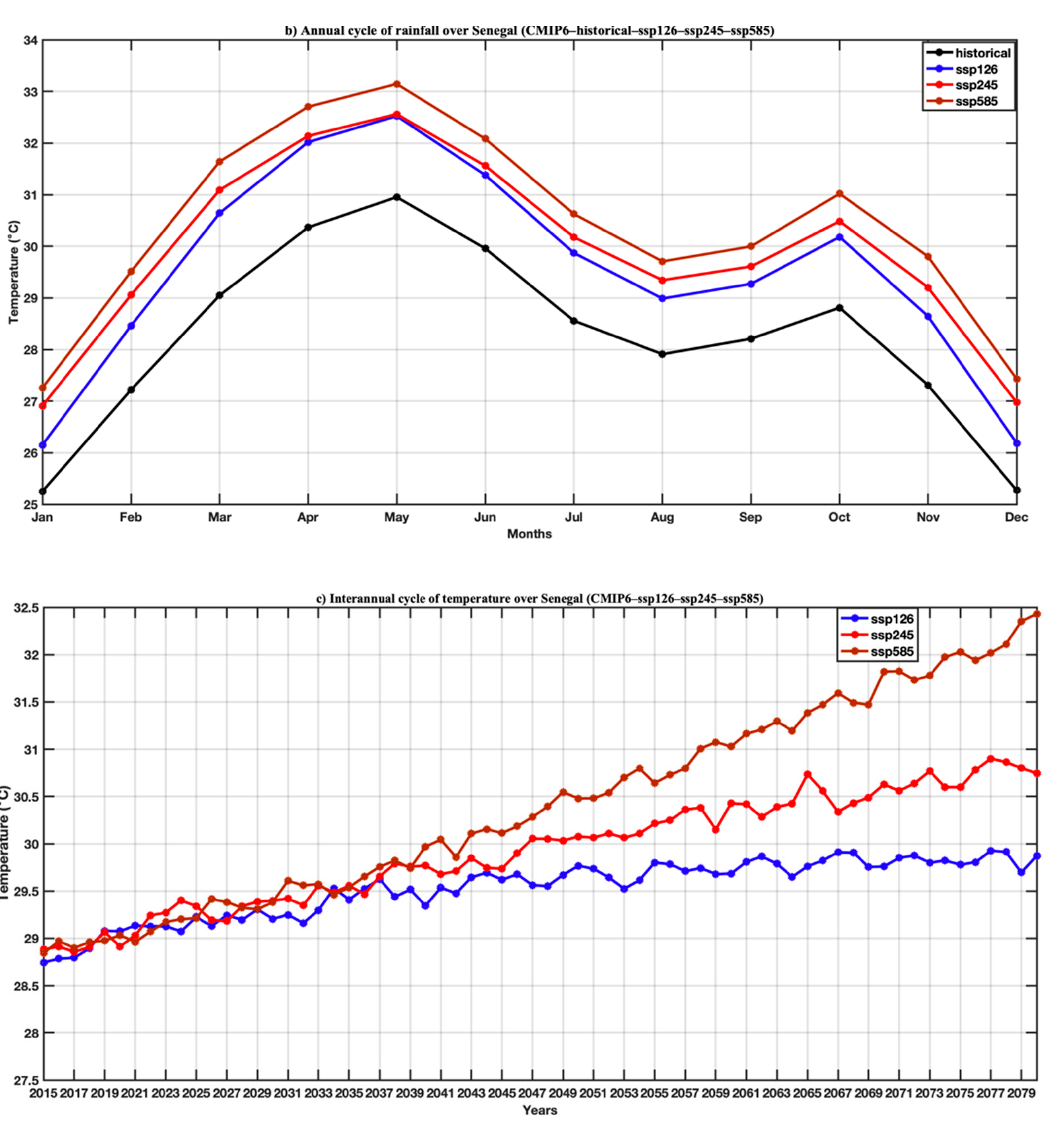
Figure 7. ( a ) Trend of average temperature over Senegal for the historical period 1950–2013 (overall average of CMIP6 models) highlighting interannual variability, decadal and multi-decadal variability, ( a , b ) respectively, annual cycle and interannual variability rainfall in Senegal with historical data (1950–2014), and ( c ) projections (2015–2080) for the SSP126, SSP245, SSP585 scenarios of the CMIP.